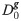
Illustration of the transformation of the original parameter space (called A) to a new one (called B) in which D is one of the parameters.The projections of the three parameter points on the red axis governing the width of the B area are denoted with open circle and these are the parameter points g. For each of these open circle points, the RT distribution scales are set to 1 (i.e., s = 1) by choosing an appropriate diffusion coefficient (denoted as D0g) and any parameter point in B can be reached by selecting an appropriate g and then adjusting the scale up- or downwards (this is indicated by the dotted lines in the length direction of the new parameter space B.